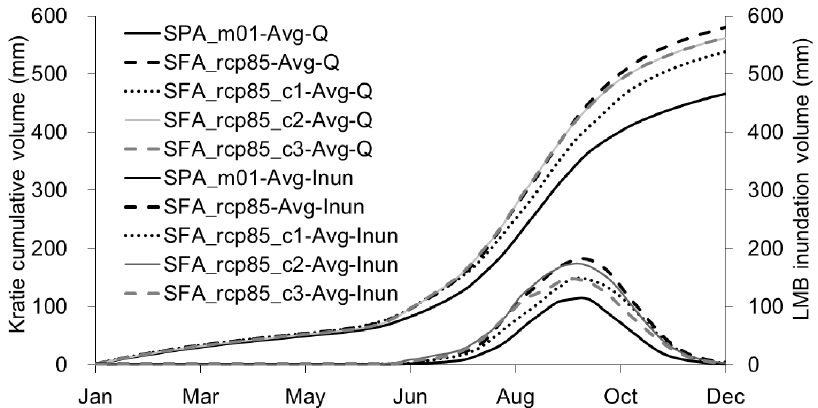
climate experiments. Hydrology 2017 , 4 , 55